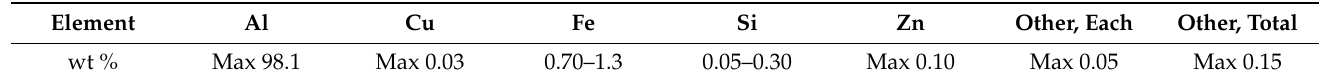
Table 2. Nominal chemical-composition of the aluminium alloy